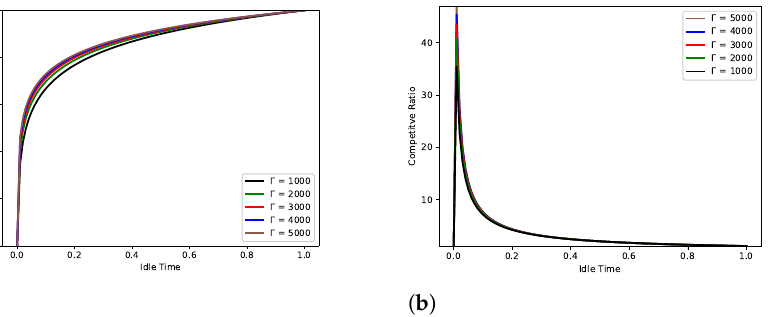
Figure 3. Logarithmic Strategy. ( a ) Transition rates for logarithmic strategies, linear system; ( b ) com- petitive ratios for logarithmic strategies, linear system.